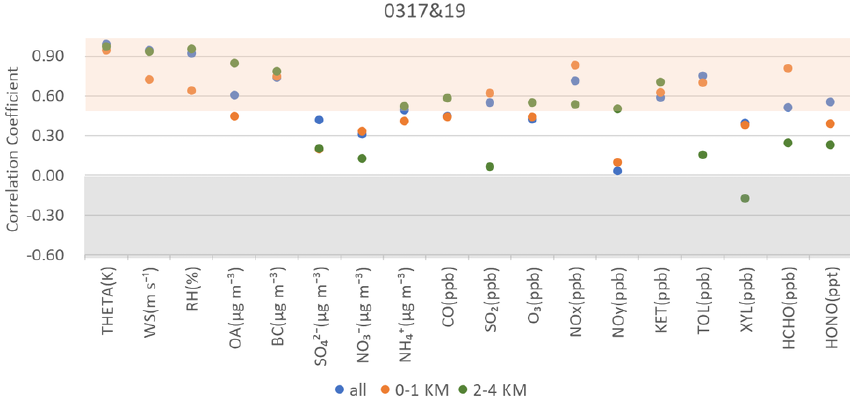
Figure 9. Correlation coefficient ( R ) between observation and simulation along with the HALO flights at the elevations 0–1km and 2–4km and the whole track (all) on 17 and 19 March 2018.